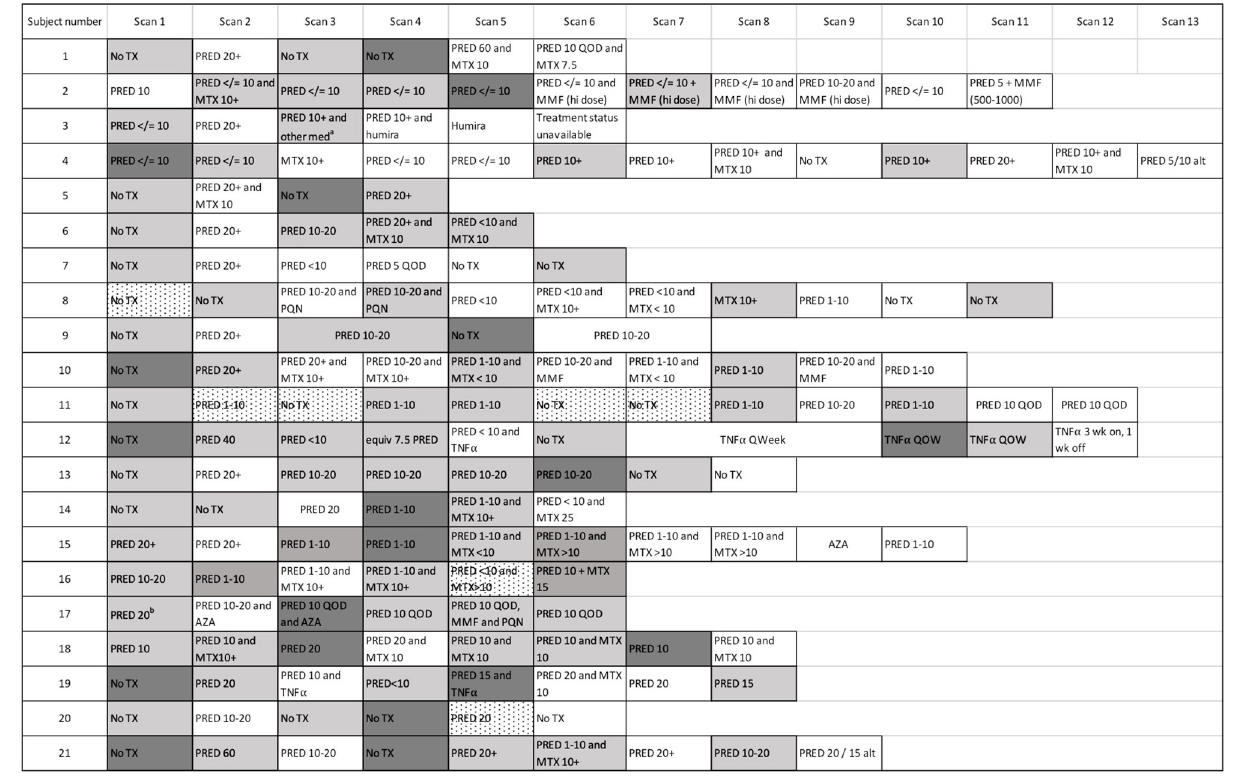
FIGURE 3 | Cardiac PET scan results and associated therapies. The number of scans across the cohort is demonstrated, with the treatment regimen associated with each scan provided. Persistently positive scans (multiple gray blocks in a row) were observed in several cases. “Scan 1” indicates the first available PET scan in our system. a ‘other med’ not qualified in clinical notes. b Prednisone 20 mg/day had been started several days before this baseline scan. White boxes: negative cardiac PET scan. Light gray boxes: positive cardiac PET scan. Dark gray boxes: scan with most extensive disease, when multiple sequential cardiac PET scans